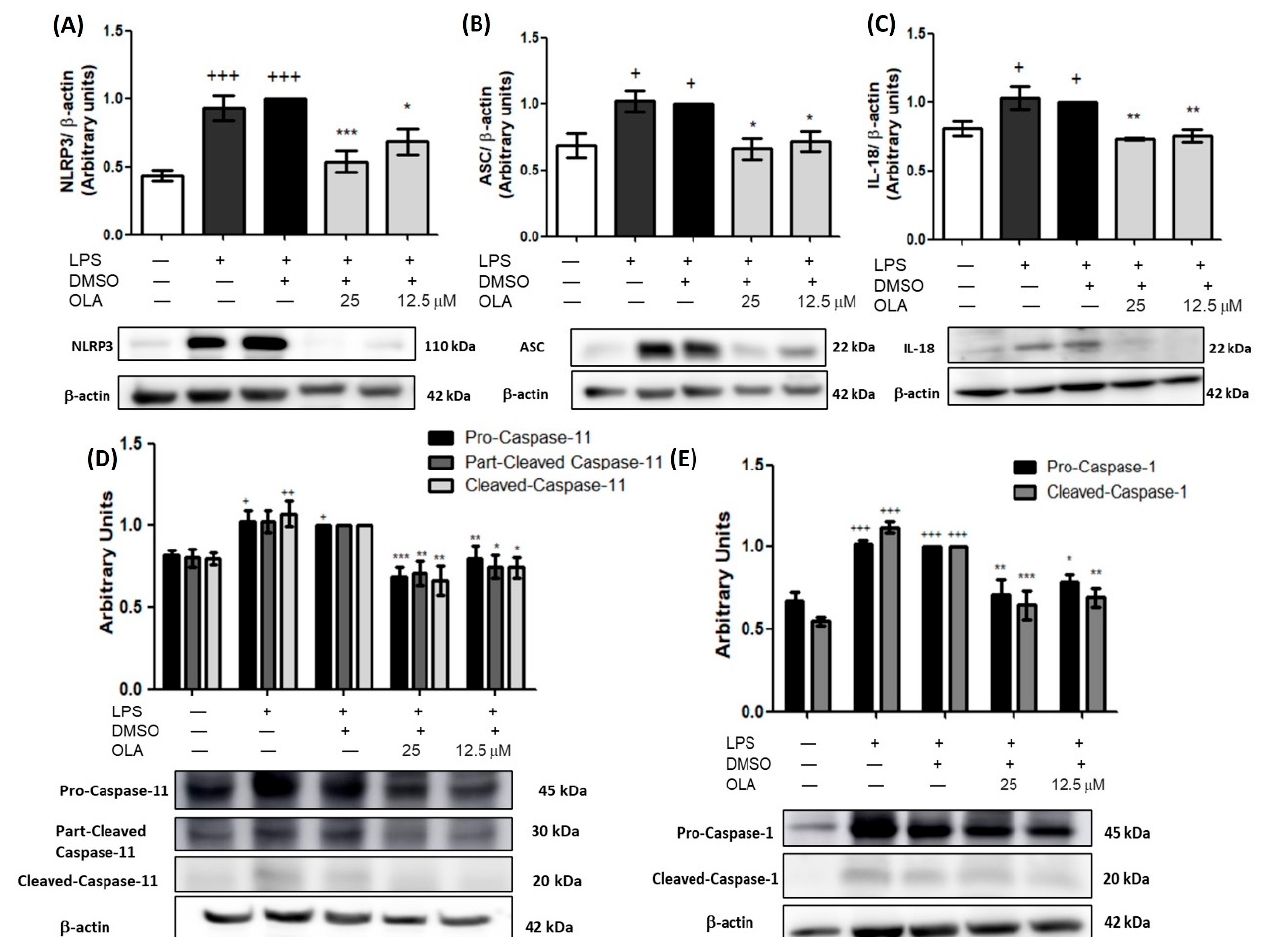
Figure 8. Inflammasome signaling pathway was downregulated by OLA in murine peritoneal macrophages. ( A ) NLRP3, ( B ) ASC, ( C ) IL-18, ( D ) pro-caspase-11, partially cleaved and cleaved, ( E ) pro-caspase-1 and cleaved-caspase-1. Protein expressions were analyzed by immunoblot. Murine peritoneal macrophages were pretreated for 30 min with OLA (25 and 12.5 µ M) followed by stimulation with 5 µ g/mL LPS for 18 h. Densitometry was performed following normalization to the control ( β -actin housekeeping gene). Data are represented as the means ± SEM ( n = 6). + p < 0.05, ++ p < 0.01, +++ p < 0.001 vs. control cells (no stimulated); * p < 0.05, ** p < 0.01, *** p < 0.001 vs. LPS − DMSO-treated cells.